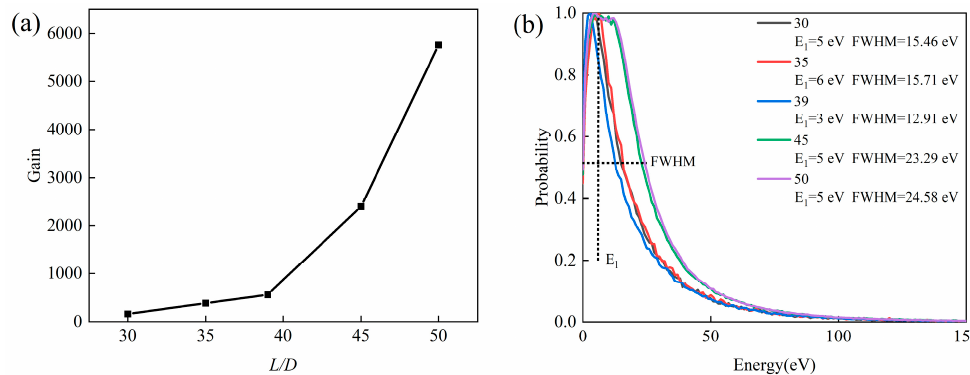
Figure 9. Effect of L / D on secondary electron multiplication at the normalized voltage ( θ = 6 o , l 2 = 6 µ m): ( a ) Gain; ( b ) The most probable exit energy distribution.